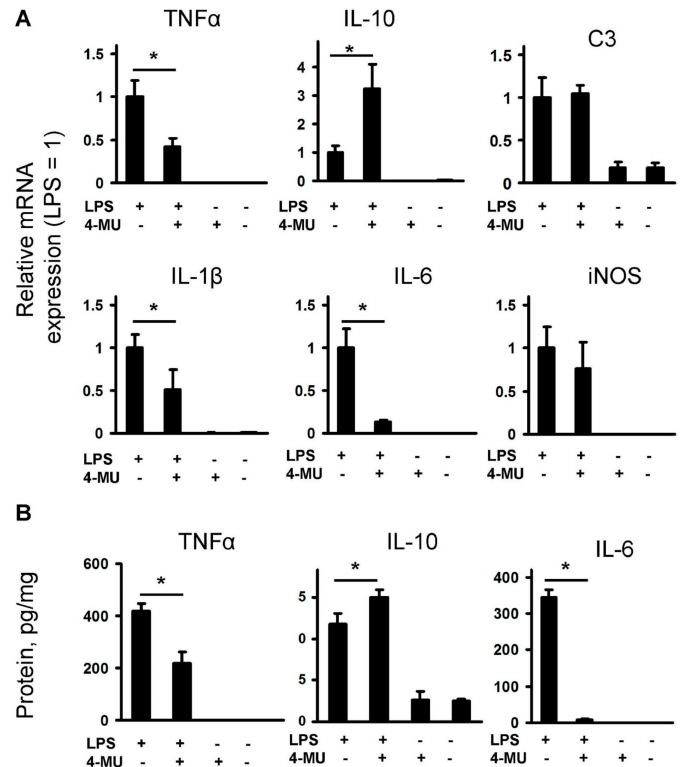
Figure 1. E ff ect of 4-MU on the inflammatory response. The primary rat astrocyte cultures were pretreated with 4-methylumbelliferone (4-MU, 400 µ M) for 30 min and then stimulated with lipopolysaccharide (LPS) (100 ng / mL) for 4 h. ( A ): the mRNA levels of inflammatory markers